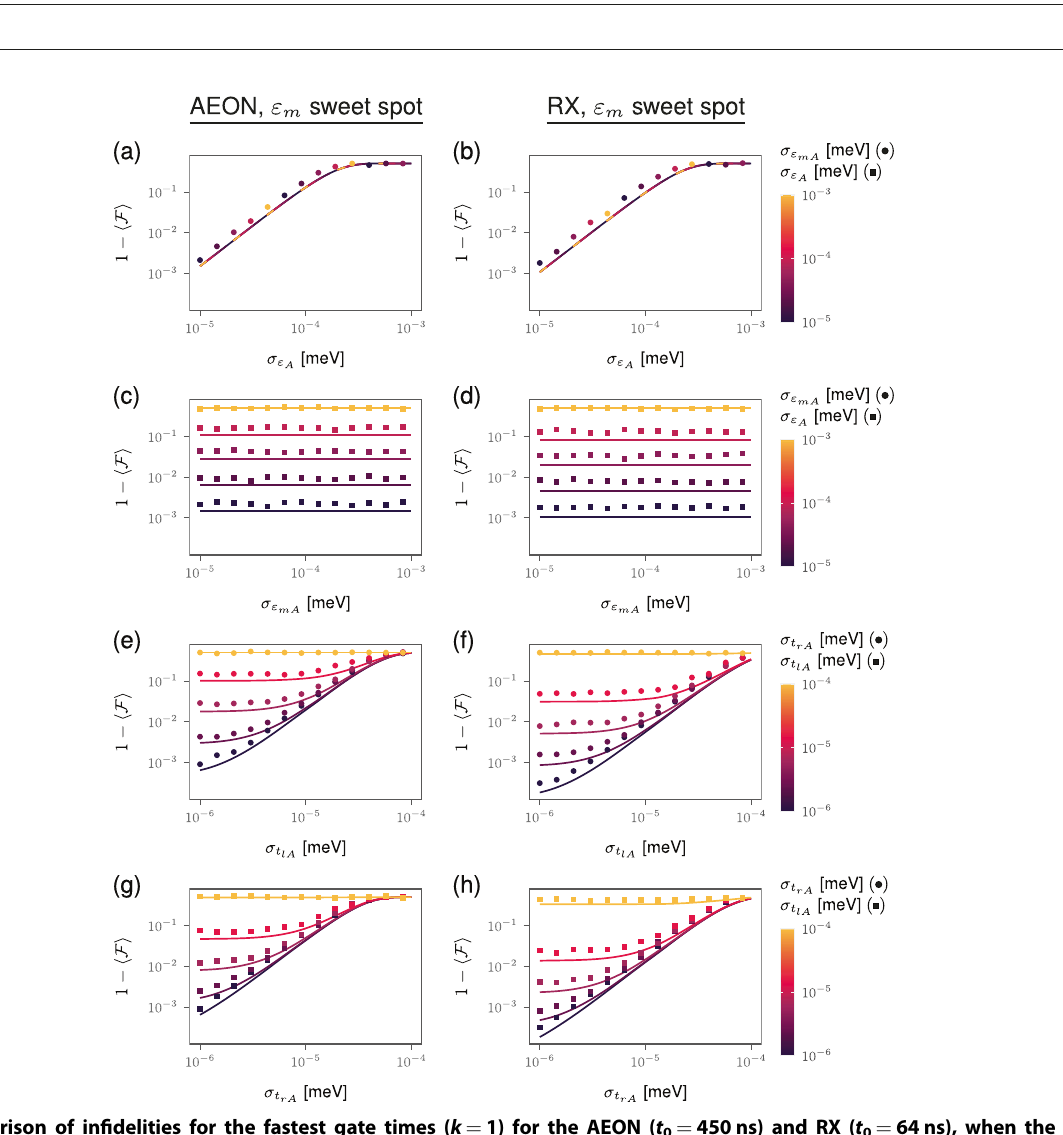
Fig. 3 Gate in fi delities under detuning or tunneling noise and 2QSS. a – h In fi delity plots of AEON with qubit A in the presence of only detuning noise ( a – d ) and only tunneling noise ( e – h ), while sitting at its single-qubit double sweet spot and the ε m 2QSS. i – p In fi delity plots of RX ( k = 7, for a comparable gate time with AEON) with qubit A in the presence of only detuning noise ( i – l ) and only tunneling noise ( m – p ), while sitting at its single-qubit single sweet spot and the ε m 2QSS. q – x In fi delity plots with qubit A in the presence of only detuning noise ( q – t ) and only tunneling noise ( u – x ), while sitting at the ε m and t l 2QSS. Panels ( a , e , i , m , q , u ) are numerical simulations (Eq. (13)) averaged over 500 ( a , e , i , m ) and 100 ( q , u ) noise realizations. Panels ( b , f , j , n , r , v ) are analytical calculations (Eq. (14)) and agree well with numerical simulations, as evident from comparisons with linecuts. Corresponding analytical and numerical plots share the same color scale. Panels ( c , k , s ) show horizontal linecuts (circles), and panels ( d , l , t ) show vertical linecuts (squares) from the numerical result in panels ( a , i , q ), and agree very well with analytical calculations (lines) at the ε m 2QSS, while analytical in fi delity overestimates by an order of magnitude for the ε m and t l double which con fi rms the ε mA 2QSS. Panel ( w ) shows that 2QSS. Panels ( d , l , t ) show that in fi delity is independent of middle detuning noise σ ε mA which con fi rms that it is the double 2QSS of ε mA and t lA . In contrast, in fi delity in fi delity is also independent of the left tunneling noise σ t lA (panels c , k , s ) because there is no such 2QSS, and in right tunneling σ t when not operated at the t rA 2QSS increases with noise detuning σ ε A rA (panels h , p , x ). Color scales in rightmost column represent the numerical value of noise amplitude at which the linecuts are taken. Results for noisy qubit B or both qubits noisy are qualitatively similar (see Supplementary Discussion 2).